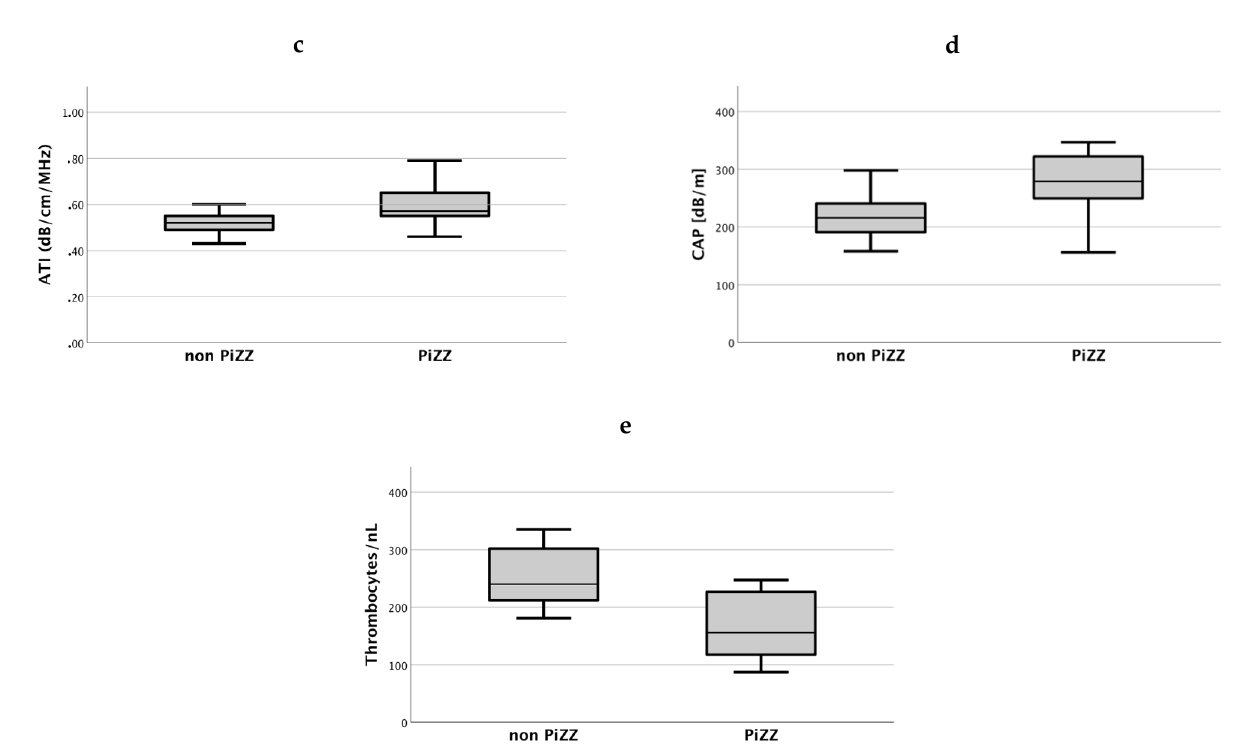
Figure 4. ( a – e ): Bars on the right-hand side display the PiZZ genotype ( n = 18), and bars on the left-hand side show other AATD genotypes ( n = 11). The measurement of SWE, ATI, CAP and thrombocytes/nl discriminate PiZZ from other AATD genotypes. All p -values < 0.05. SWE: shear wave elastography; ATI: attenuation imaging; CAP: controlled attenuation parameter.